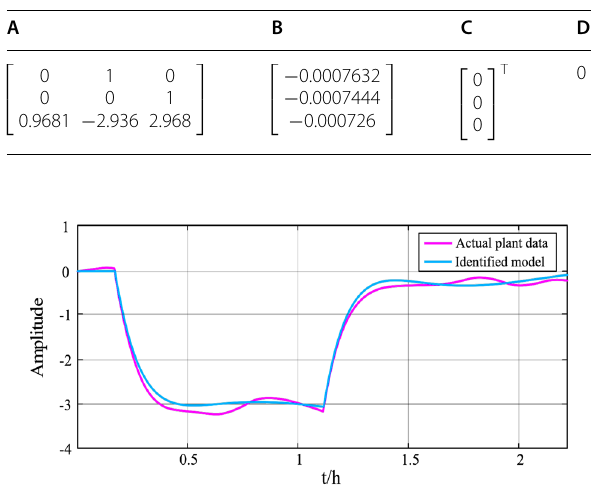
Fig. 4 Fitting curves of actual plant data and linear model